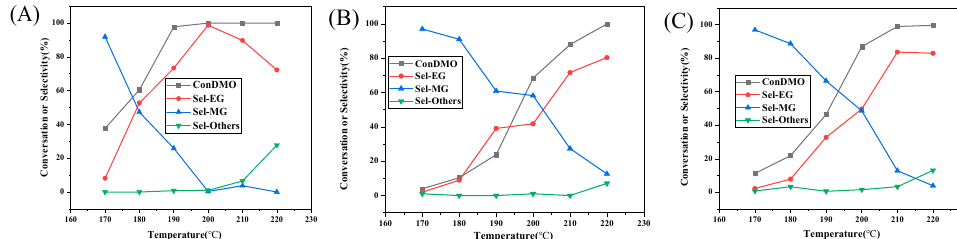
Figure 5. Catalytic performance of MOF-CmS ( A ), MOF-CS ( B ), and CS ( C ) samples in different